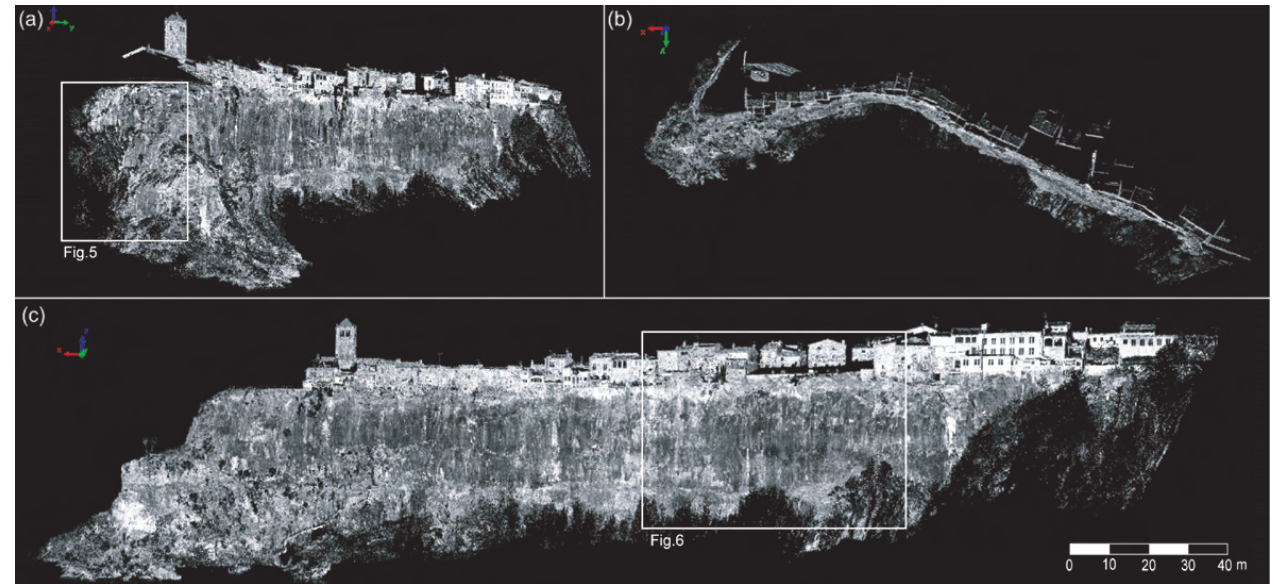
Fig. 3. Images of the aligned TLS datasets: (a) left view: “–X axis”; (b) zenithal view: “+Z axis”; (c) frontal view: “–Y axis”. The position of the Figs. 5 and 6 are indicated in Fig. 3a and c,